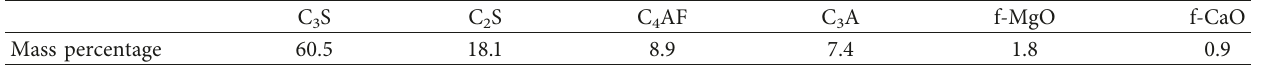
Table 1: The primary mineral composition of 42.5 ordinary Portland cement (wt.%).